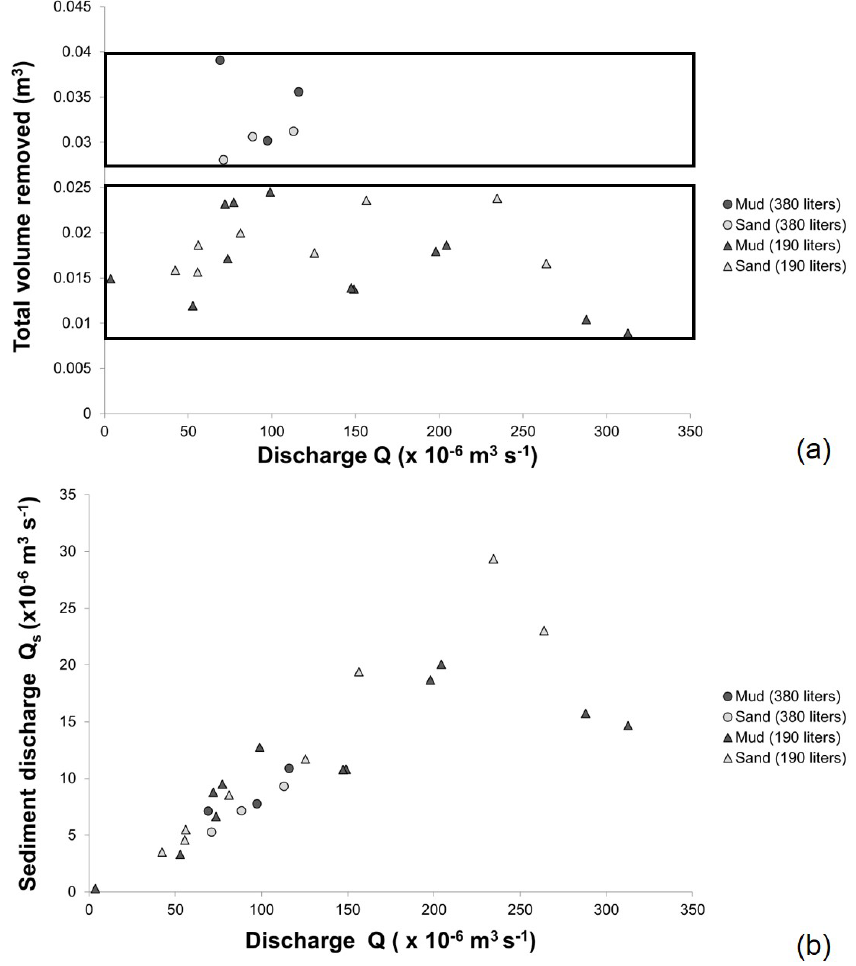
Figure 3. The results from these experiments show that the total volume of sediment removed is not dependent on flow rate (a) or that sediment discharge is linearly related to water discharge (b) . These charts also show that while sediment discharge is the same for the 380L runs as it is for the 190L runs at a given discharge, the total volume of sediment removed is greater in the 380L runs.